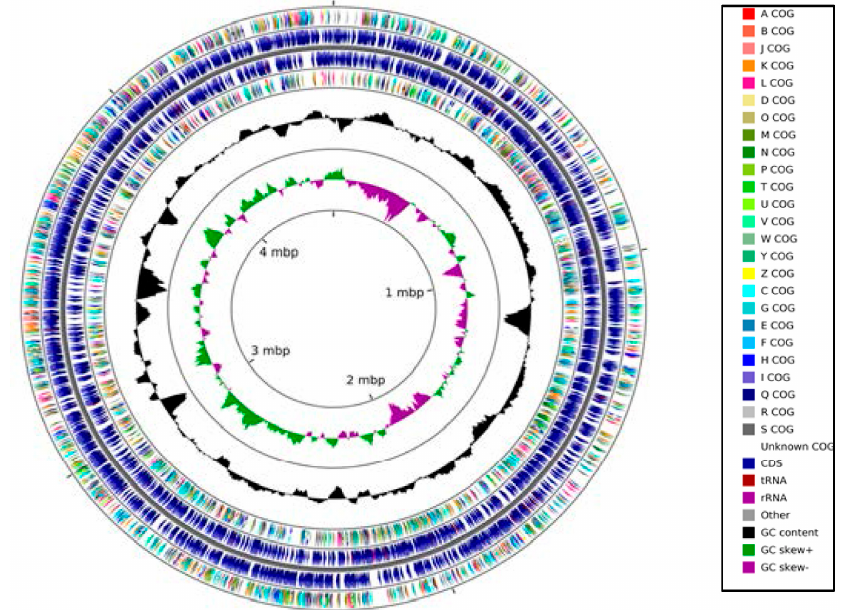
Figure 2. Circular genome map of Arthrobacter sp. strain SRS-W-1-2016 with the first (outermost) and fourth rings depicting clusters of orthologous groups of proteins (COG) categories of protein coding genes on the forward and reverse strands, respectively. The second and third rings show the locations of protein coding, tRNA, and rRNA genes on the forward and reverse strands, respectively. The black plot depicts GC content with the peaks extending towards the outside of the circle representing GC content above the genome average, whereas those extending towards the center mark segments with GC content lower than the genome average. The innermost plot depicts GC skew. Both base composition plots were generated using a sliding window of 50,000 nt.